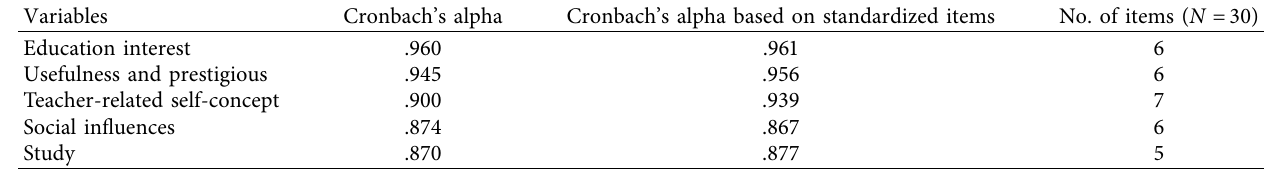
Table 2: Reliability of measuring the instrument (according to Cronbach’s alpha model).